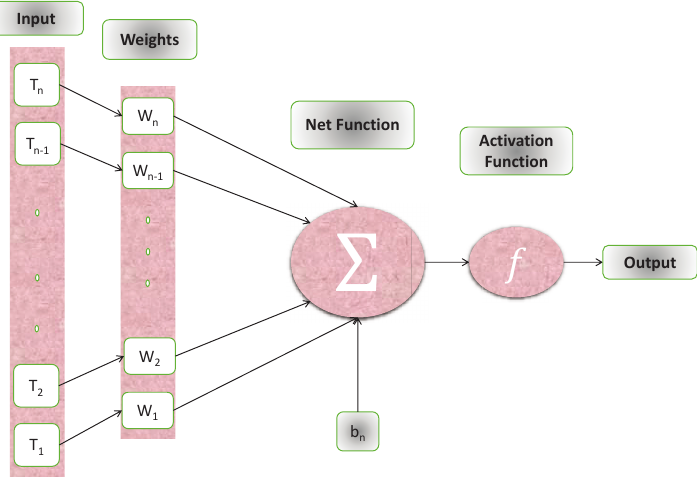
Figure 1. Architecture of artificial neural networks with single